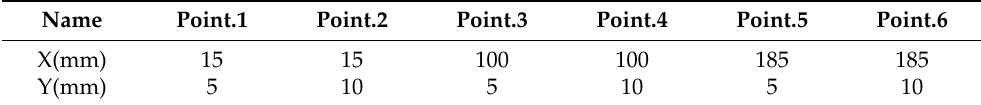
Table 3. The coordinates of the six probe points in the porous bed.